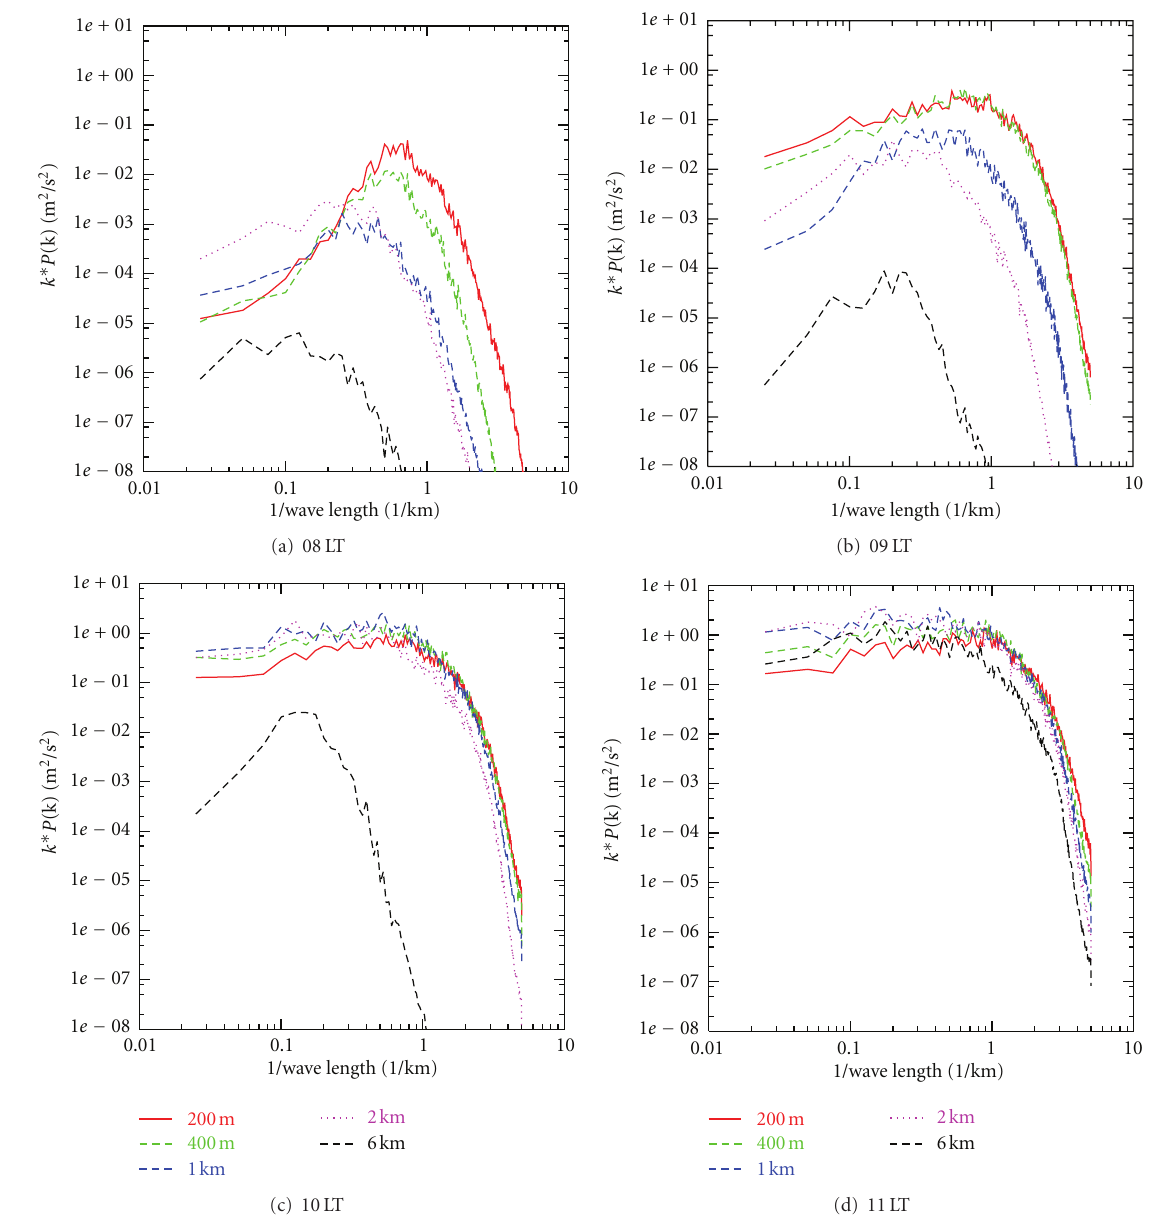
Figure 6: The same as Figure 5 except for